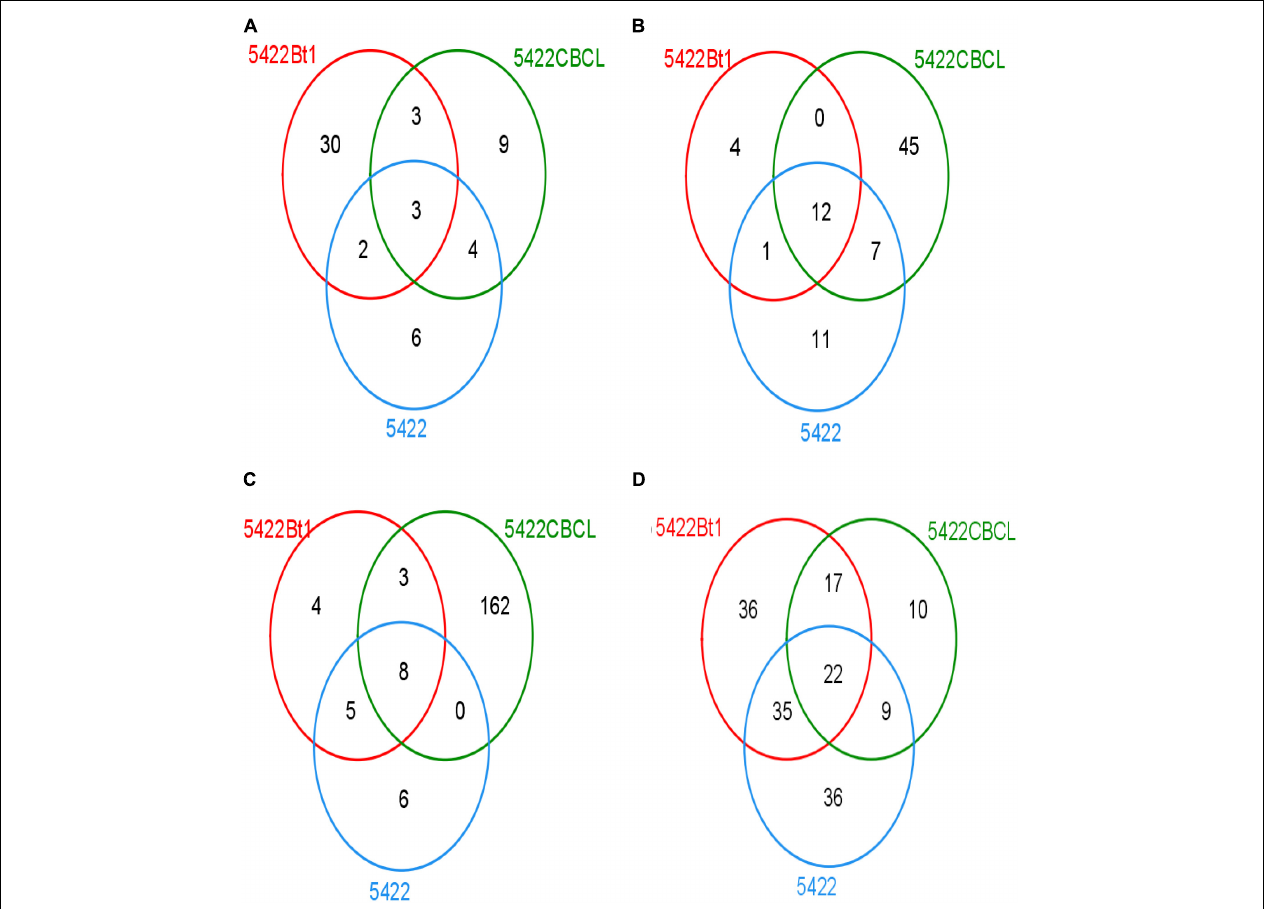
FIGURE 3 | Venn diagram depicting OTUs that are shared or unique in root and soil samples. (A) Venn diagram of OTUs detected in roots of maize varieties cultivated for consecutive five seasons. (B) Venn diagram of OTUs detected in rhizosphere soils of maize varieties cultivated for consecutive five seasons. (C) Venn diagram of OTUs detected in roots of conventional maize variety cultivated with straw of the 5 th maize varieties. (D) Venn diagram of OTUs detected in rhizosphere soils of conventional maize variety cultivated with straw of the 5 th maize varieties.